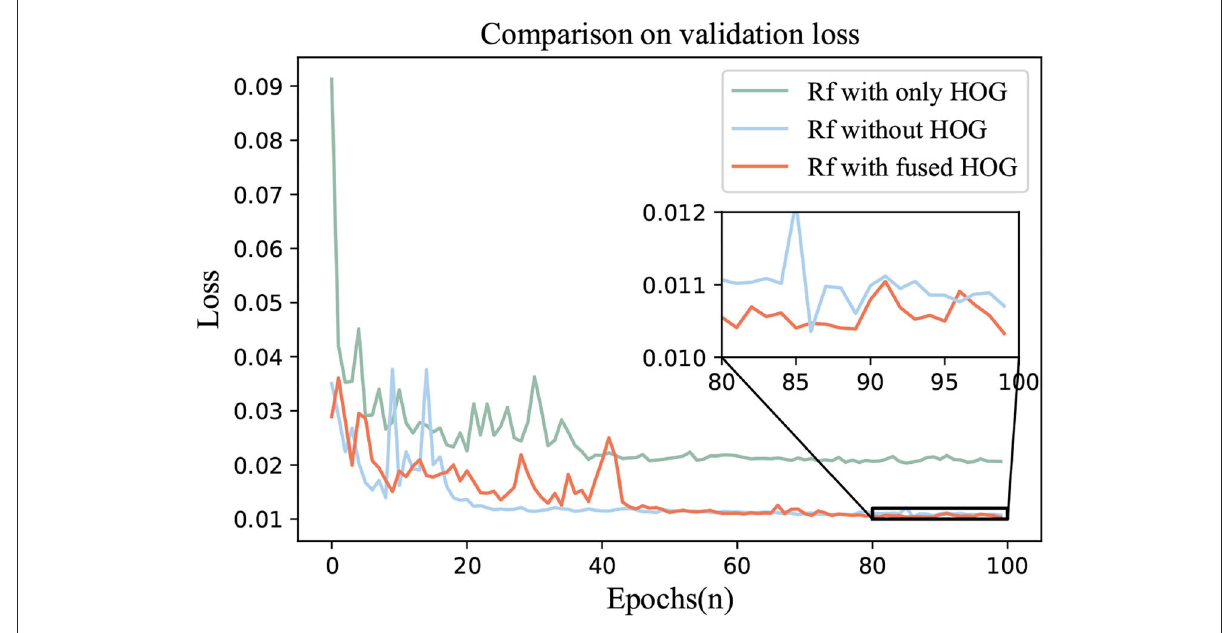
FIGURE8 Comparison of loss values in ablation experiment.